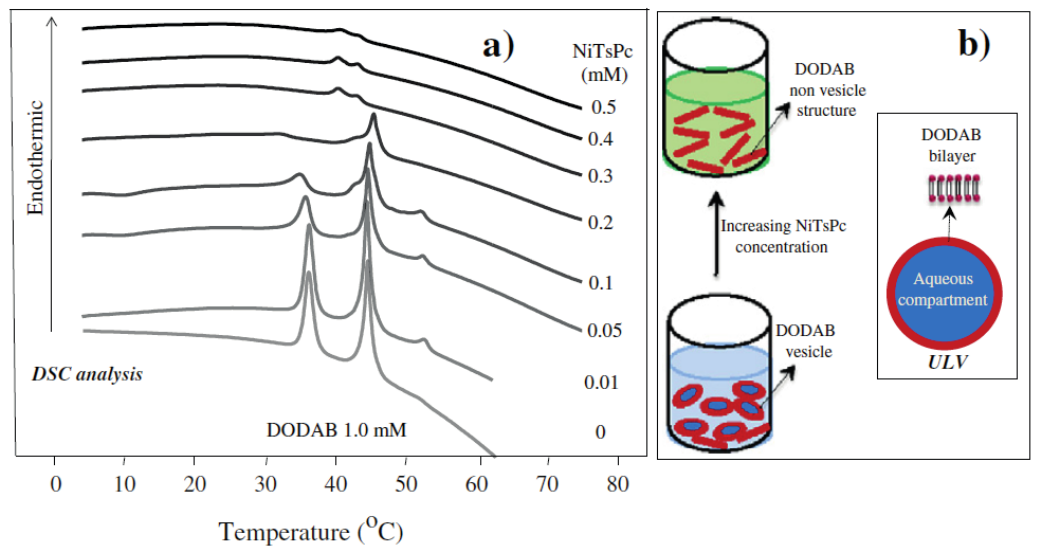
Figure 6 - ( a ) heating DSC thermograms for 1.0 nmol/l DODAB in the absence and presence up to 0.5 mol/l NiTsPc. ( b ) Schematic representation of the possible structures of DODAB in the presence of NiTsPc solution (UlV and non-vesicle structures). Reprinted with permission (Furini et al.